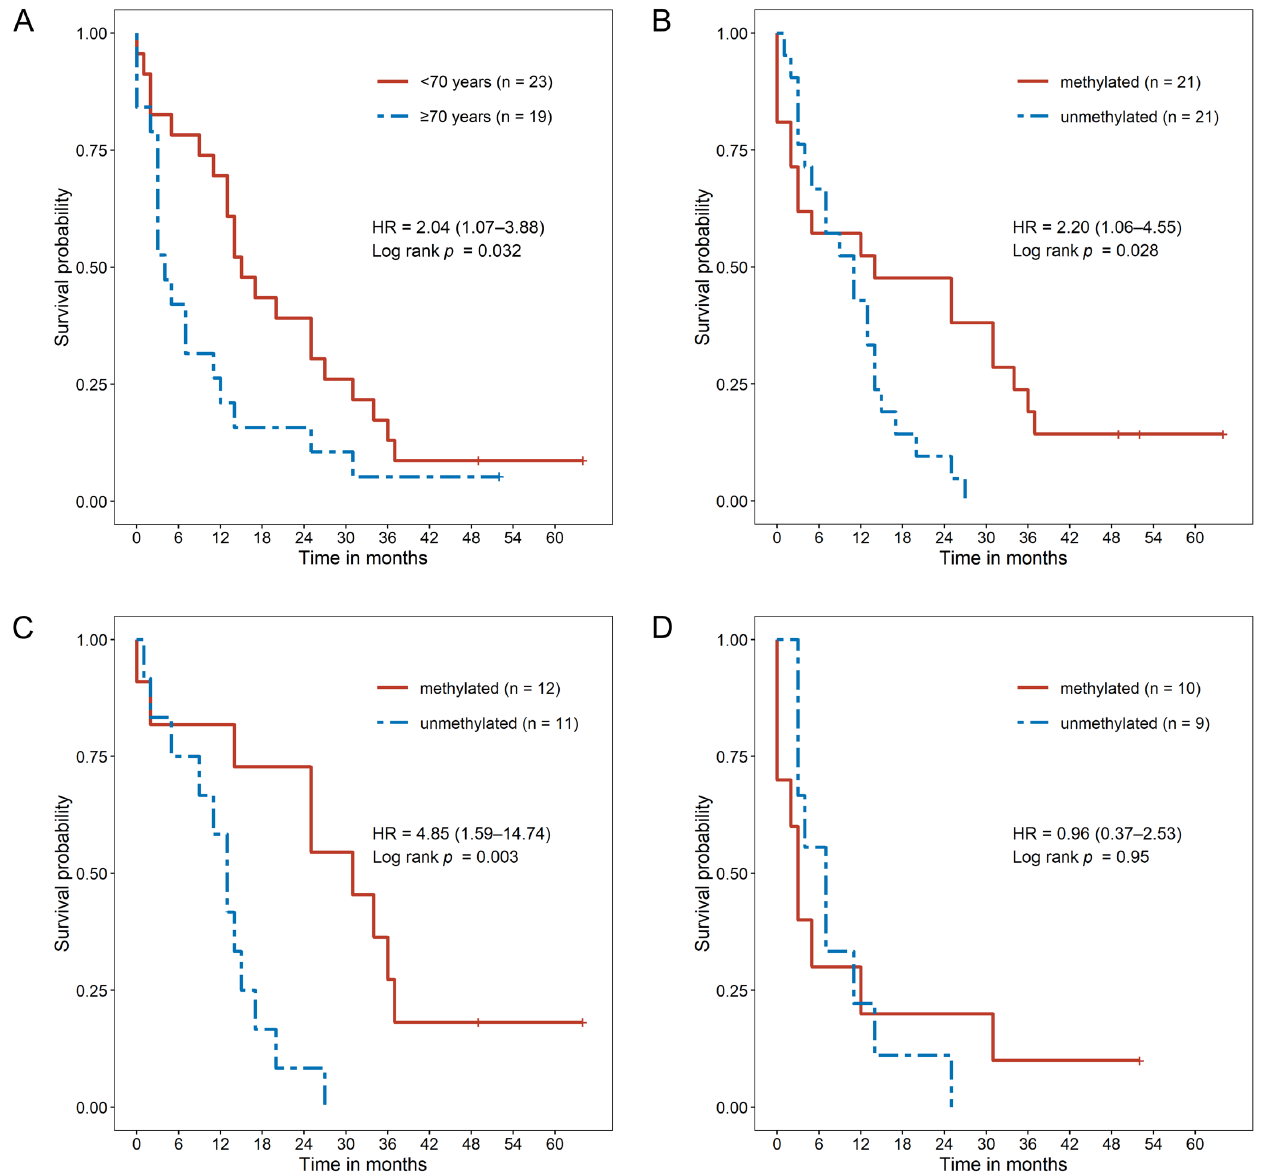
Figure 1. Kaplan–Meier estimates of overall survival (OS) in patients with glioblastoma WHO grade IV. ( A ) OS of patients stratified by age at diagnosis younger than 70 years and older than 70 years. ( B ) OS of patients stratified by MGMT promoter methylation status. ( C ) OS in patients younger than 70 years, comparing MGMT promoter methylation. ( D ) OS in patients older than 70 years, comparing MGMT promoter methylation. The hazard ratio (HR) and the 95% confidence interval in are stated in brackets. Statistical significance between the groups was evaluated using a log - rank test.